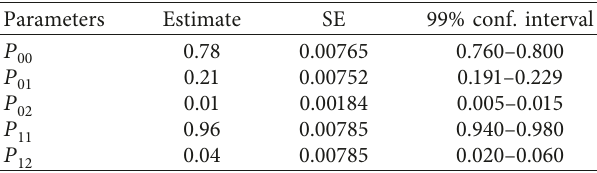
Table 7: ML estimates of transition probabilities for